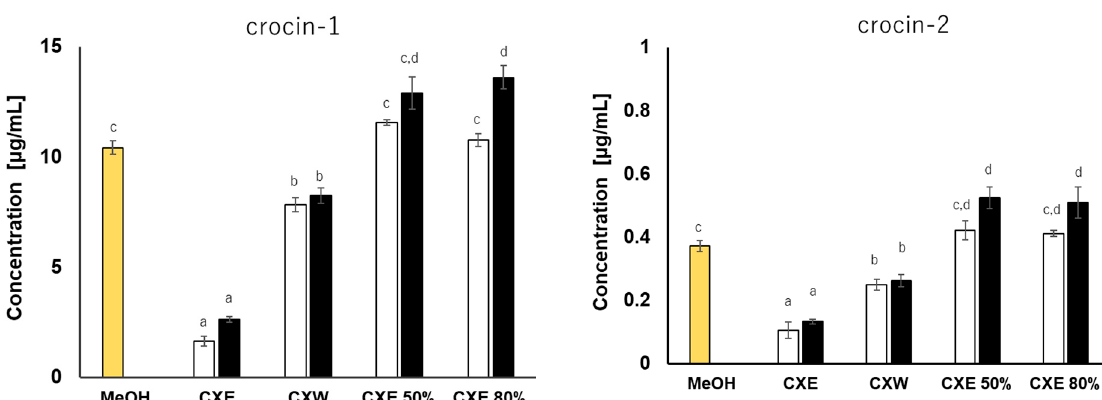
Figure 4. Effect of different modifiers on extraction concentration of crocin-1 and crocin-2 in CO 2 -expanded liquid (CXL) extraction system with ( ■ ) or without ( □ ) direct sonication (125 s, 20% amplitude) at 25 °C and 10 MPa. Error bars represent means ± SE (n = 3). Letters on top of the columns represent significant differences among methods at the 0.05 level.